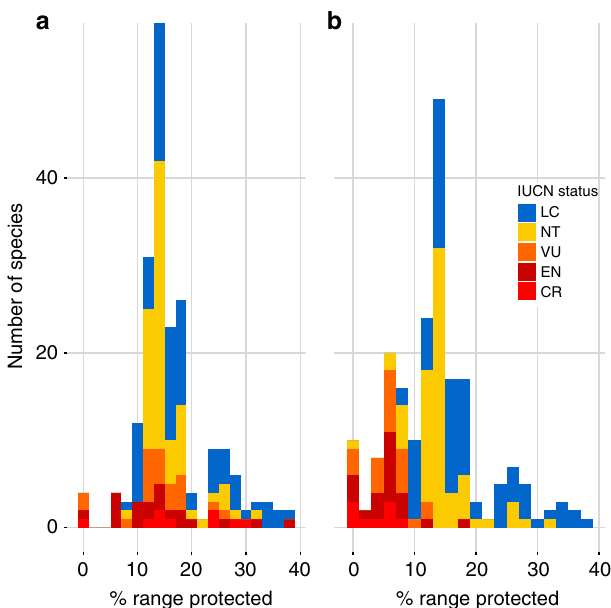
Fig. 5 Area of suitable habitat inside protected areas. Histogram of the number of regionally endemic forest-dependent bird species (77 in total) against percentage of a species ’ range that falls within a protected area (PA; IUCN category I – V); bar colour represents IUCN status based on our analysis. a The percentage of the range within PAs, and b the percentage of the range protected within PAs once exploitation-susceptible areas (i.e., within 5 km of a forest edge) have been